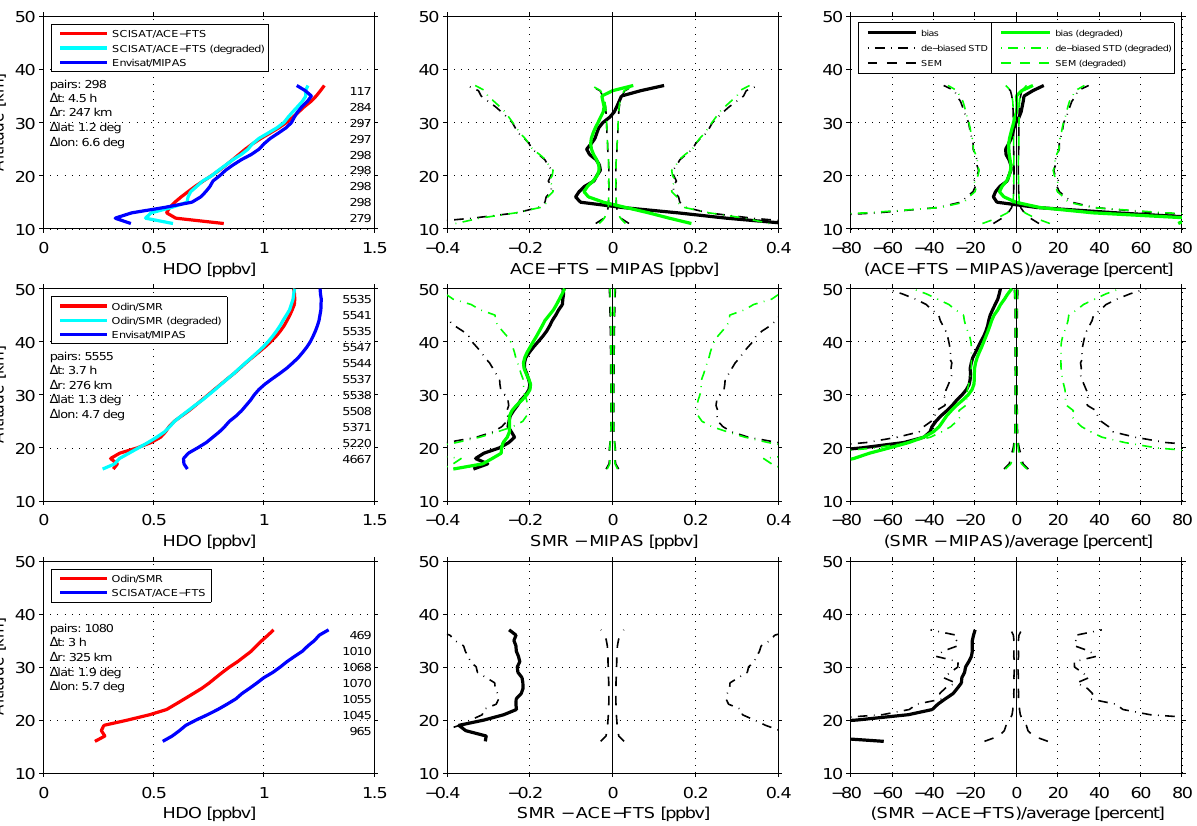
Fig. 2. Profile-to-profile comparisons of coincident HDO observations between MIPAS and ACE-FTS (upper panels), MIPAS and SMR (middle panels) and SMR and ACE-FTS (lower panels). The panels on the left-hand side show the mean profiles based on the coincident sets of data. The absolute biases are shown in the middle panels, the relative biases are given in the panels on the right-hand side. The dash-dotted lines represent the estimated combined precision of the data sets under comparison, while the dashed lines indicate the standard error of the derived biases. In the middle and right-hand panels the black lines show the results of direct comparisons, while green is used for the comparisons which involve the degradation of the vertical resolution of one data